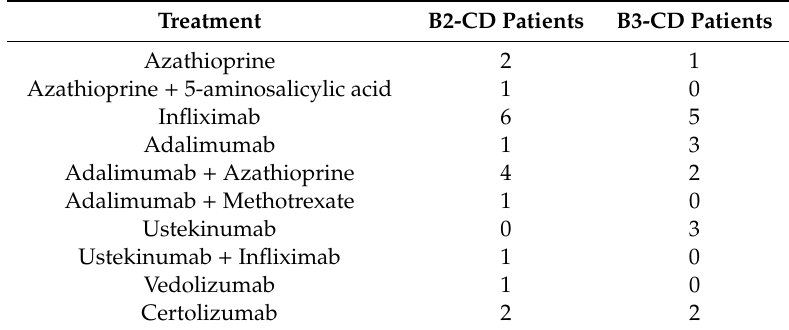
Table 2. Information of patient